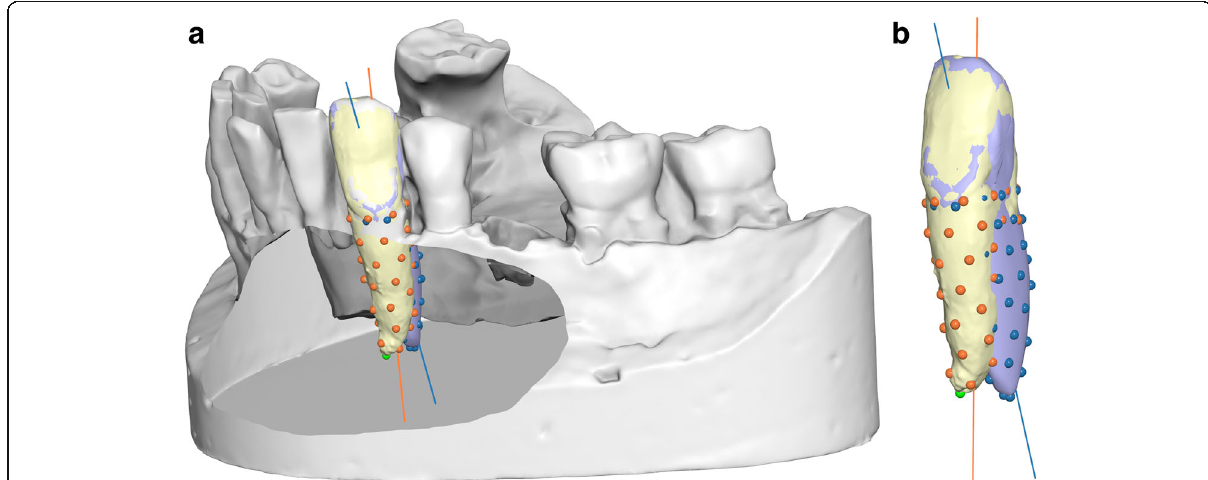
Fig. 4 The long axes of the actual and estimated roots of the canine, as computed by the Viewbox software. The dots on each root represent points evenly distributed on each root (50 points per root). The lines are best-fit lines to these points